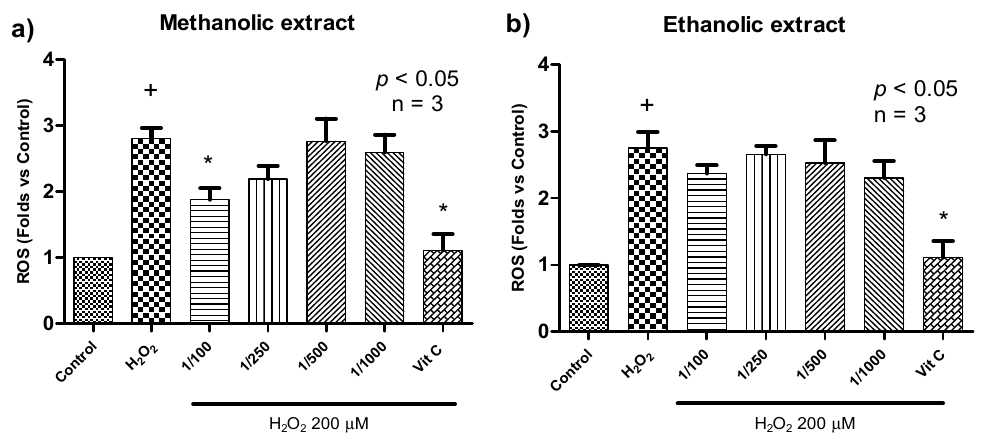
Figure 1. Protective e ff ect of calafate extract on reactive oxygen species (ROS) production upon H 2 O 2 stimulation. ( a ) methanolic extract diluted at 1 / 100 (2 mg FW / mL), 1 / 250 (0.8 mg FW / mL), 1 / 500 (0.4 mg FW / mL), and 1 / 1000 (0.2 mg FW / mL). ( b ) Ethanolic extract diluted at 1 / 100 (2 mg FW / mL), 1 / 250 (0.8 mg FW / mL), 1 / 500 (0.4 mg FW / mL), and 1 / 1000 (0.2 mgFW / mL). Intracellular ROS levels were determined by H 2 DCF-DA fluorescence (10 µ M) ( λ ex 485 nm; λ em 540 nm) in cells previously incubated with extract and then exposed to H 2 O 2 . Vitamin C (250 µ g / mL) was used as the antioxidant control. Data are presented as the mean ± standard error values. + p < 0.05 vs. control (negative control). * p < 0.05 vs. H 2 O 2 control (positive